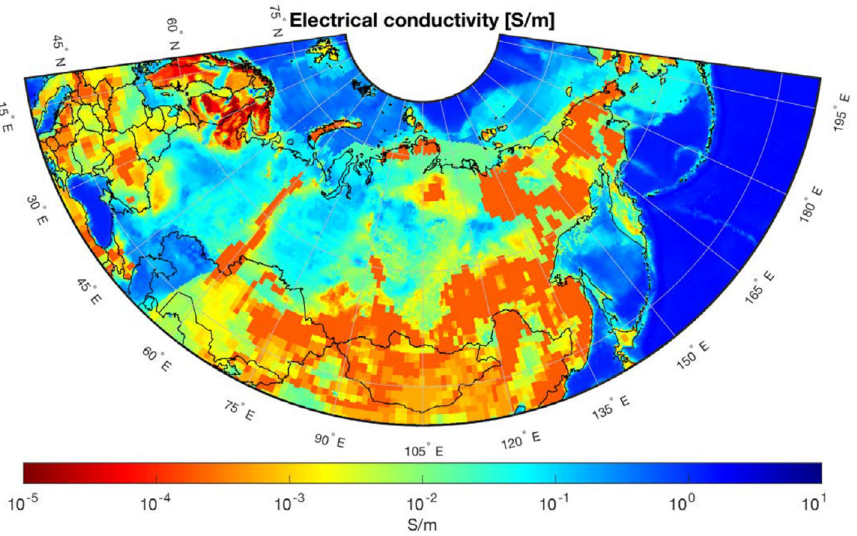
Figure 9. Map of the spatial distribution of the average conductivity σ [S/m] in the upper 10 km of the conductivity model [30] in the territory of the Russian Federation.